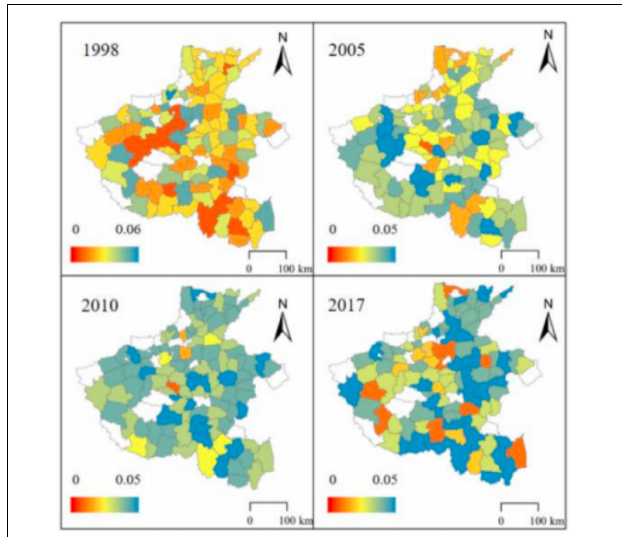
FIGURE 9 | Spatial difference of food security function of cultivated land in Henan Province.